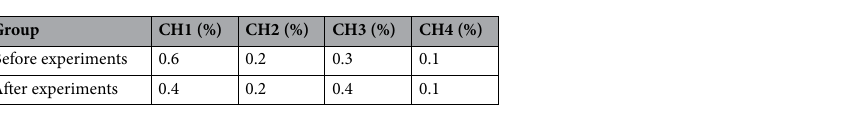
Table 5. The average value of the sensor output